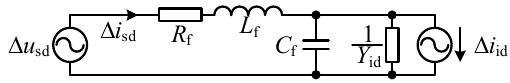
Figure 4. Small signal d-axis input circuit of the UMC.